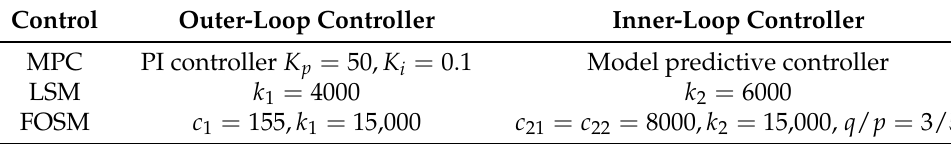
Table 2. Controller design parameters for the rectifier side.